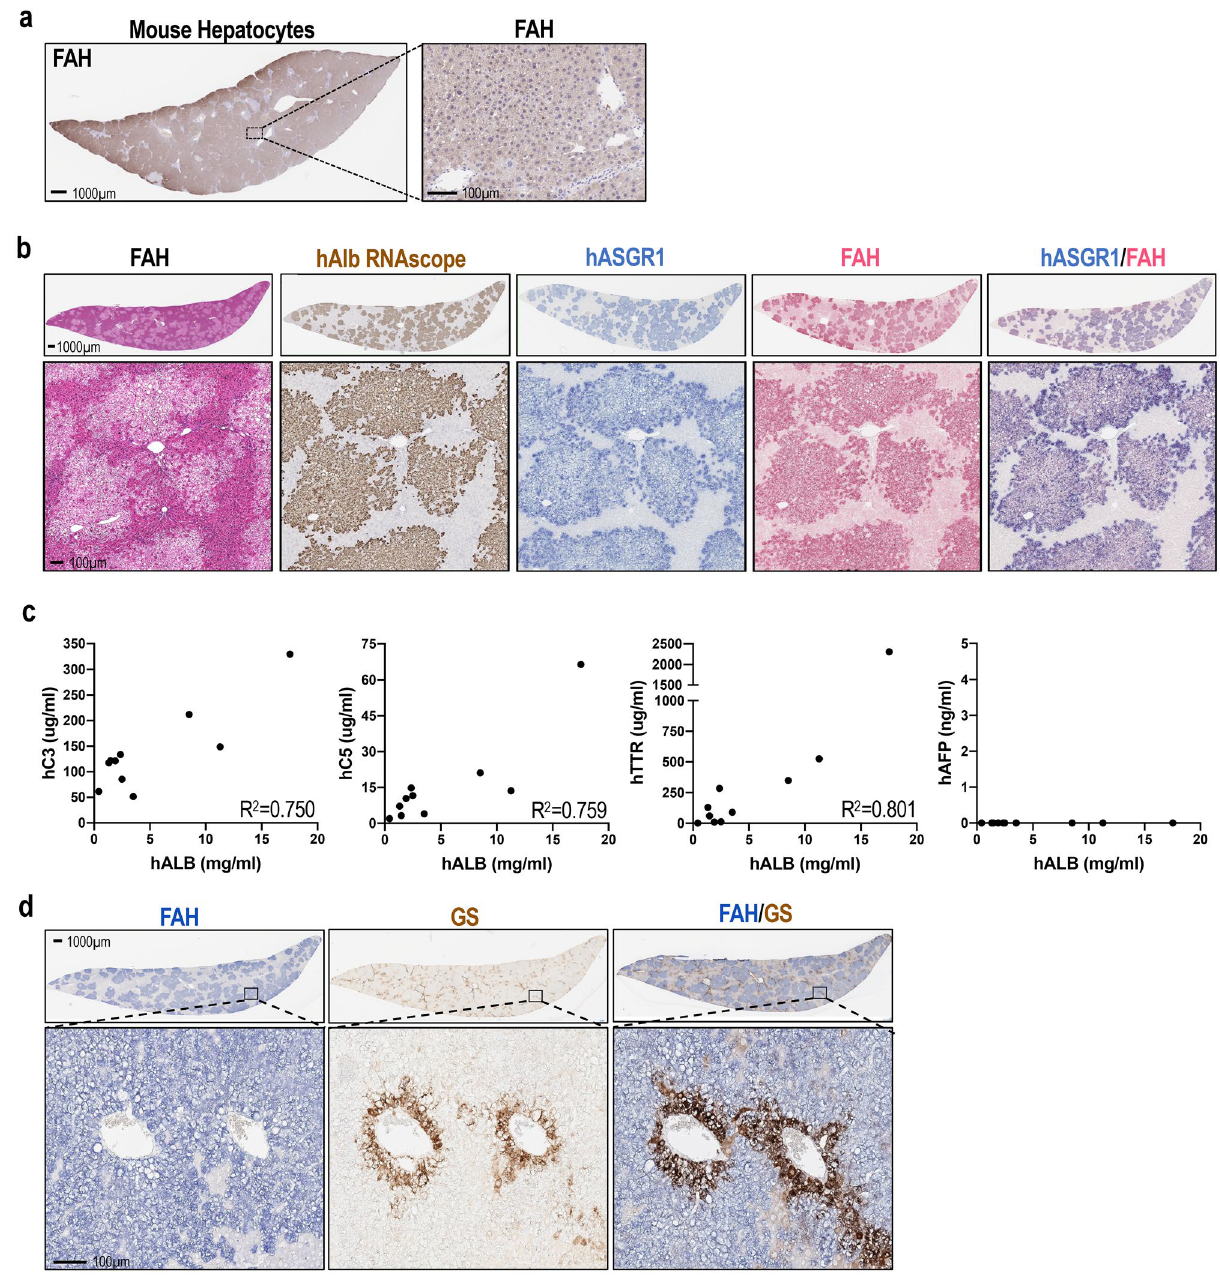
Figure 3. Cross species engraftment of donor hepatocytes and liver humanization in FRG rats. ( a ) Engraftment of murine hepatocytes in FRG rats, shown by FAH IHC. ( b ) A highly engrafted humanized liver rat showing pale H&E staining characteristic of engrafted human hepatocytes, and confirmed by positive human albumin RNAscope staining and colocalization of FAH and human ASGR1 IHC staining. ( c ) Correlation of human albumin (mg/ml), human complement proteins, C3 and C5 (μg/ml), human TTR (μg/ml) and human AFP (ng/ml) in the serum of rats engrafted with primary human hepatocytes. ( d ) GS staining in FAH-positive hepatocytes around the central vein confirms that humanized livers maintain proper liver